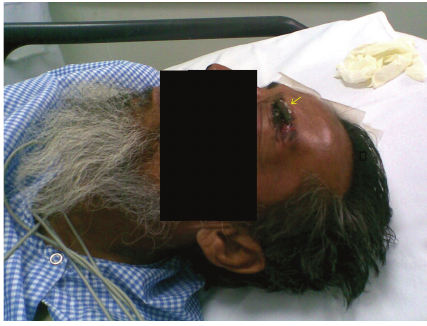
Figure 1: Figure showing the broken end of knife (yellow arrow).